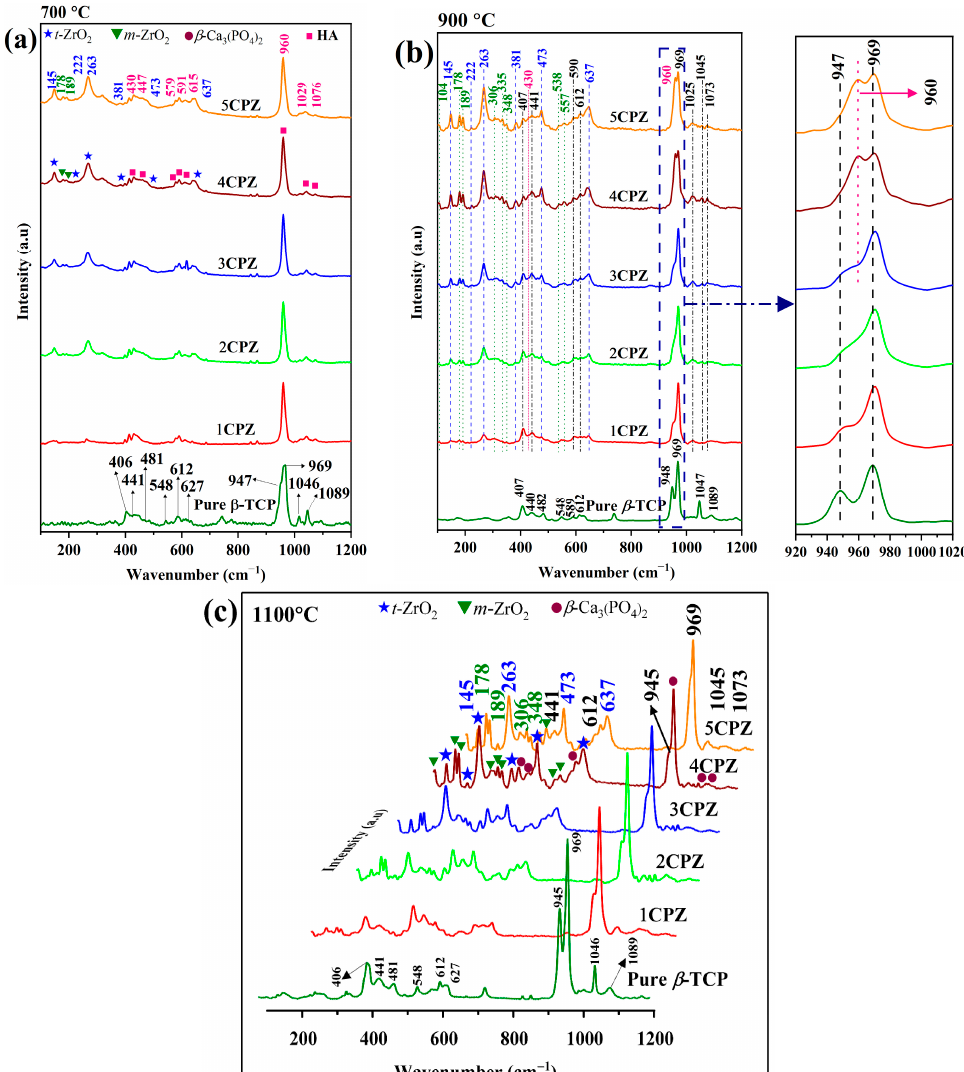
Figure 3. Raman spectra of the β -Ca 3 (PO 4 ) 2 –ZrO 2 composites after heat treatment at ( a ) 700 °C , ( b ) 900 °C, and ( c ) 1100 °C .